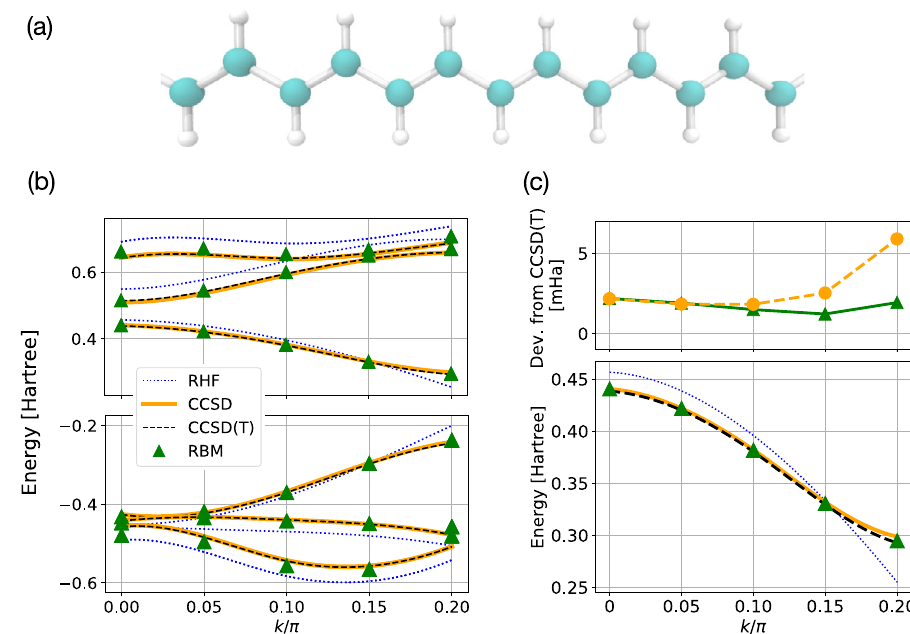
Fig. 4 Quasiparticle band spectra from multiple excited-state calculation. a Schematic diagram of the trans-polyacetylene (C 2 H 2 ) n . The cyan and gray spheres indicate the carbon and hydrogen atoms, respectively. b Three quasiparticle bands below and above the Fermi energy. Here, the yellow lines and black dashed lines indicate results obtained from the equation-of-motion coupled-cluster (EOM-CC) formalism; CCSD and CCSD(T) stand for the unperturbed EOM-CCSD and the perturbed EOM-CCSD(T)(a)*methods, respectively. The blue dotted lines denote the restricted Hartree – Fock (RHF) method. c A zoom-in of the fi rst conduction band, which is computed from the electron attatchment (EA) energy. It is clearly shown, from the energy differences against the EA-EOM-CCSD(T)(a)* method, that the results by the RBM (green triangle) are comparable or better than the unperturbed EA- EOM-CCSD method. In all calculations, a single k -point is taken under the minimal basis set (STO-3G) and hence 24 spin orbitals are taken into account. The size of the unit cell is taken as 2.451 Å